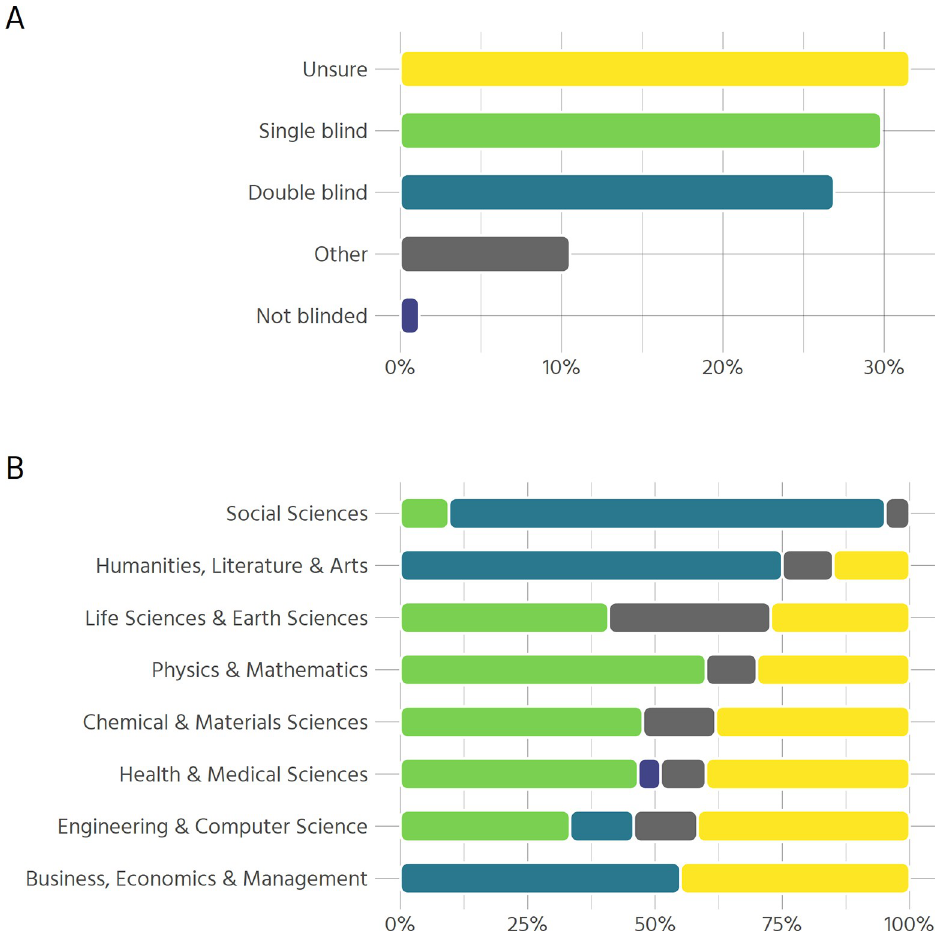
Fig 3. Type of peer review employed by journals. (A) Type of peer review used overall (n = 171) (B) Type of peer review used by disciplines (n =